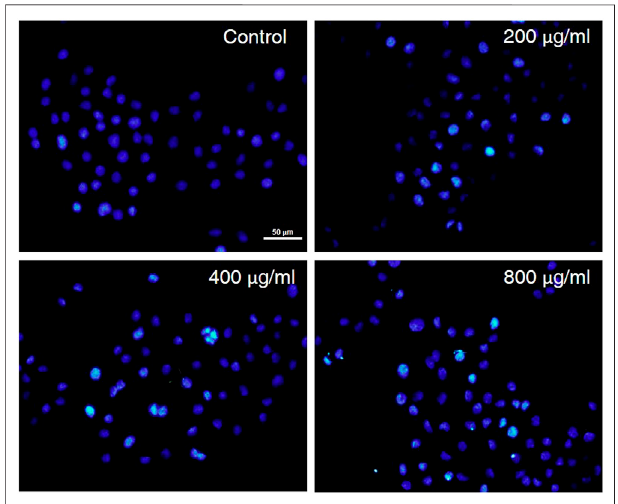
FIGURE 4 | The in fl uence of CCS2 on AGS cell morphology. AGS cells were treated with fl uorescent dyes and observed under fl uorescence microscopyafter treatment without orwithCCS2 (0,200, 400and 800 μ g/ml) for 48 h. Scale bar = 50 μ